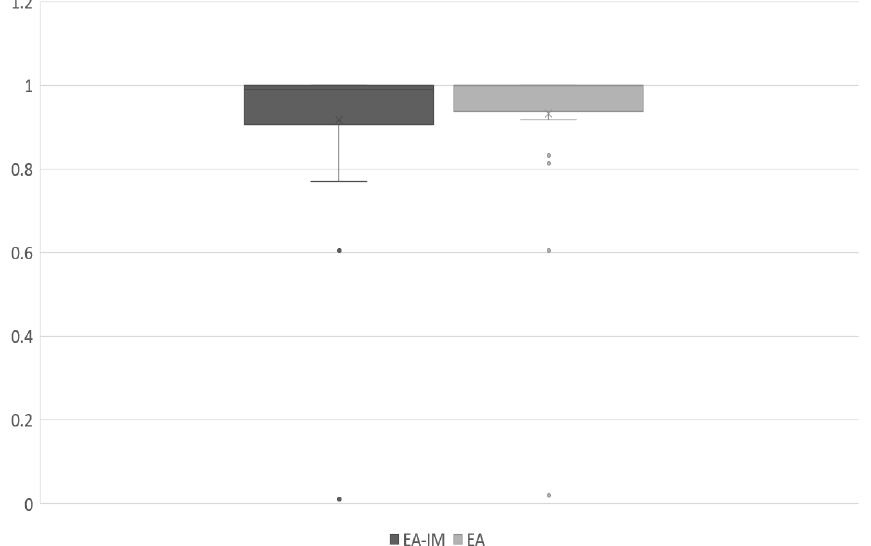
Figure 10. Comparison of EA-IM and EA on the Box-and-whisker Plot in terms of